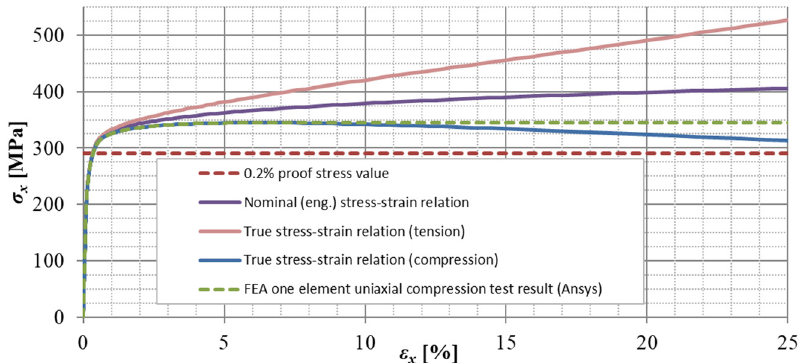
Figure 3. Material model verification by one element uniaxial tests (106 × 3-400-FR)